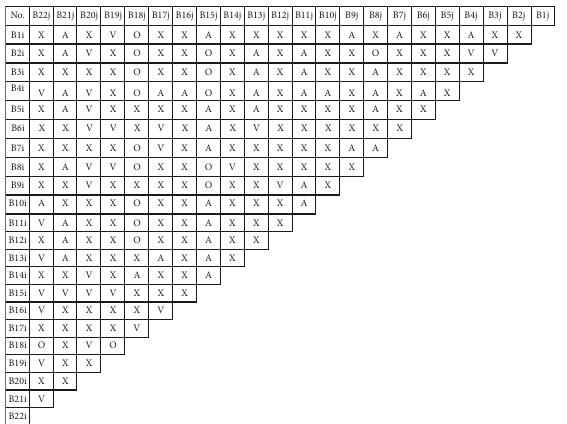
Table 8: ISSM from expert 5. Expert 5 No. B22j B21j B20j B19j B18j B17j B16j B15j B14j B13j B12j B11j B10j B9j B8j B7j B6j B5j B4j B3j B2j B1j B1i X A X V O X X A X X X X X A X A X X A X